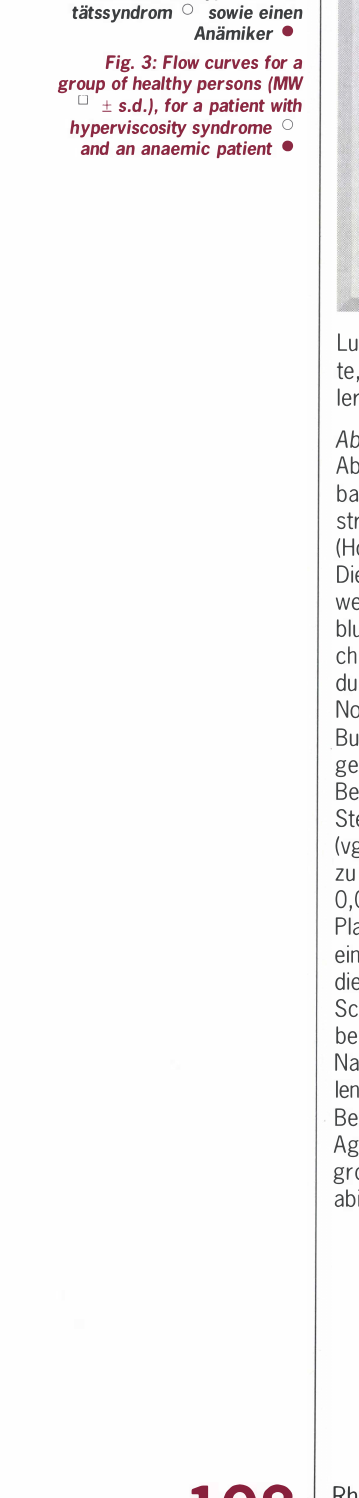
Fig. 4: Apparent absolute vis­ cosity for erythrocytes at dif­ ferent volume concentrations in autolegic